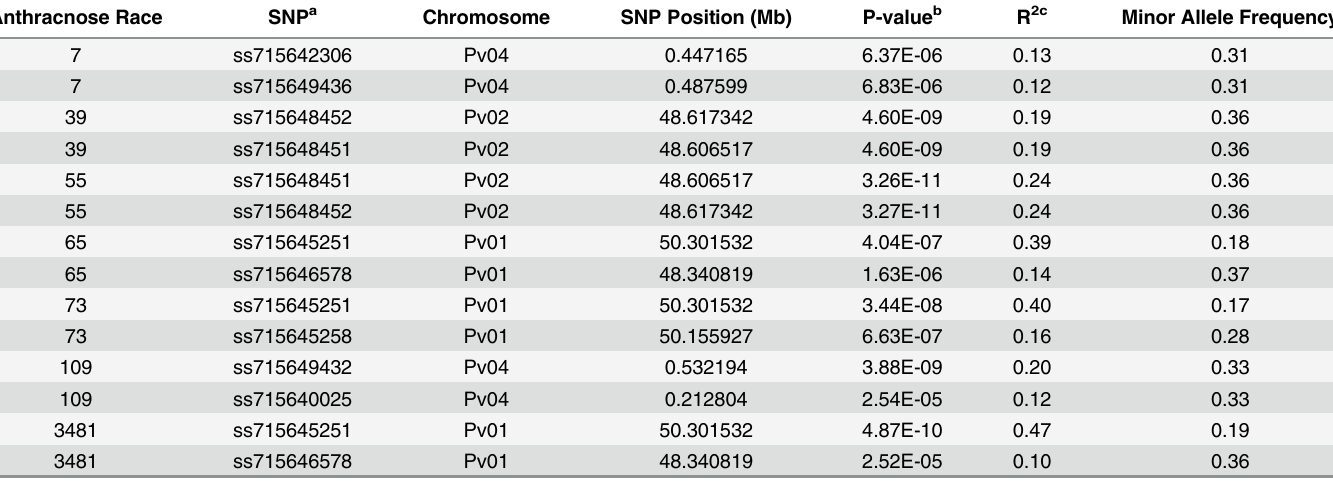
Table 1. Chromosome, position, p-value, proportion of phenotypic variation explained (R 2 ) and minor allele frequency of the two most significant SNPs for seven races of anthracnose resistance measured on 226 Andean bean genotypes. Anthracnose